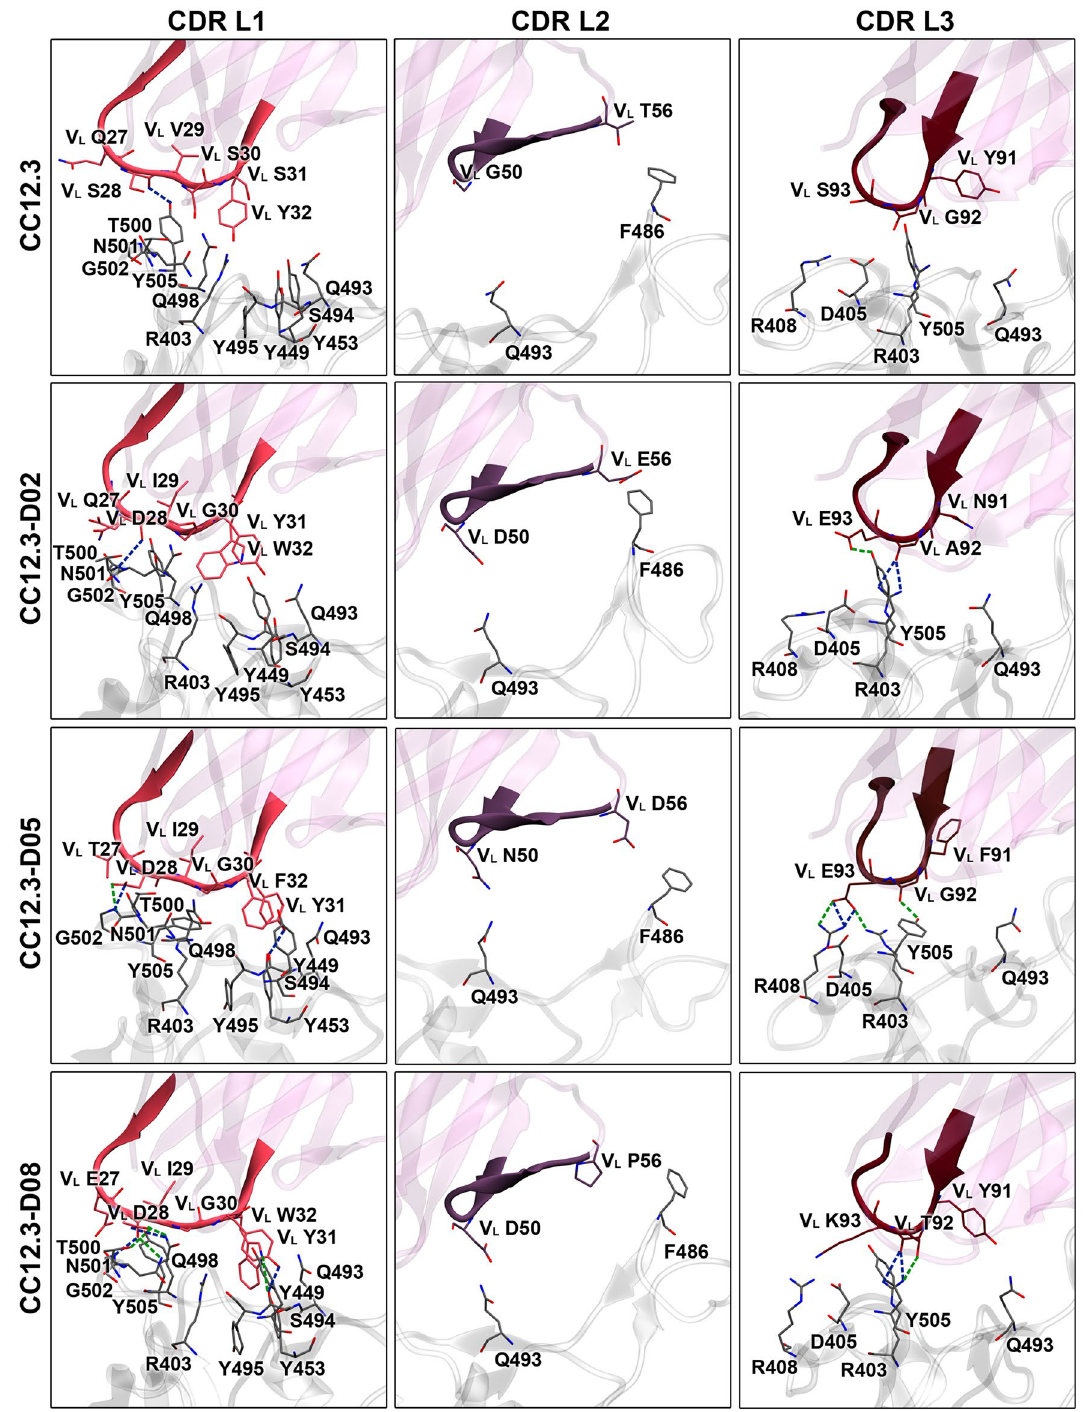
Figure 5. Key binding interactions between SARS-CoV-2-RBD and light chains of CC12.3, CC12.3-D02, CC12.3-D05, and CC12.3-D08. Strong and medium hydrogen bonds are shown in blue and green dashed lines,